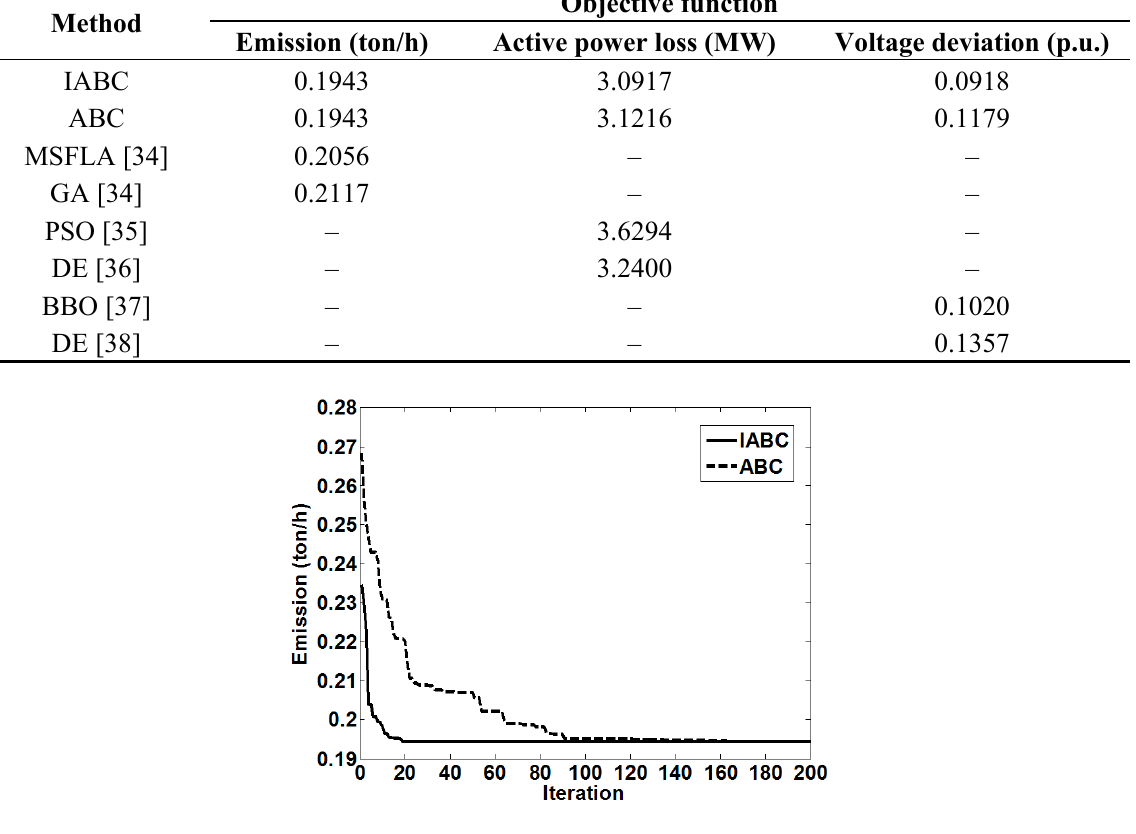
Figure 8. Convergence characteristics of total emission of the IABC and ABC algorithms for the IEEE 30-bus